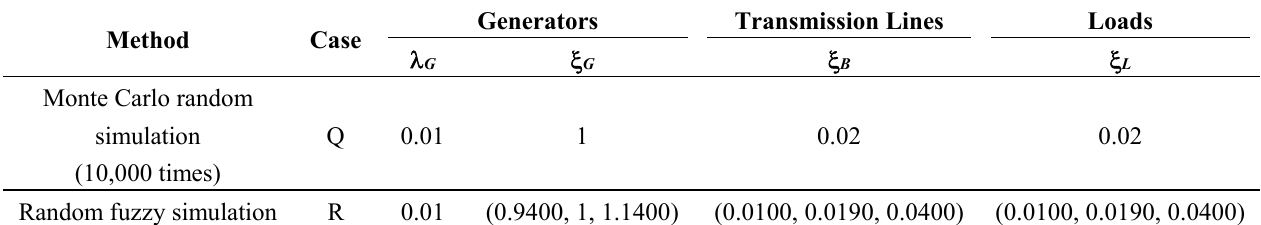
Table 12. The parameters of generators, transmission lines and loads for Case Q and Case R.